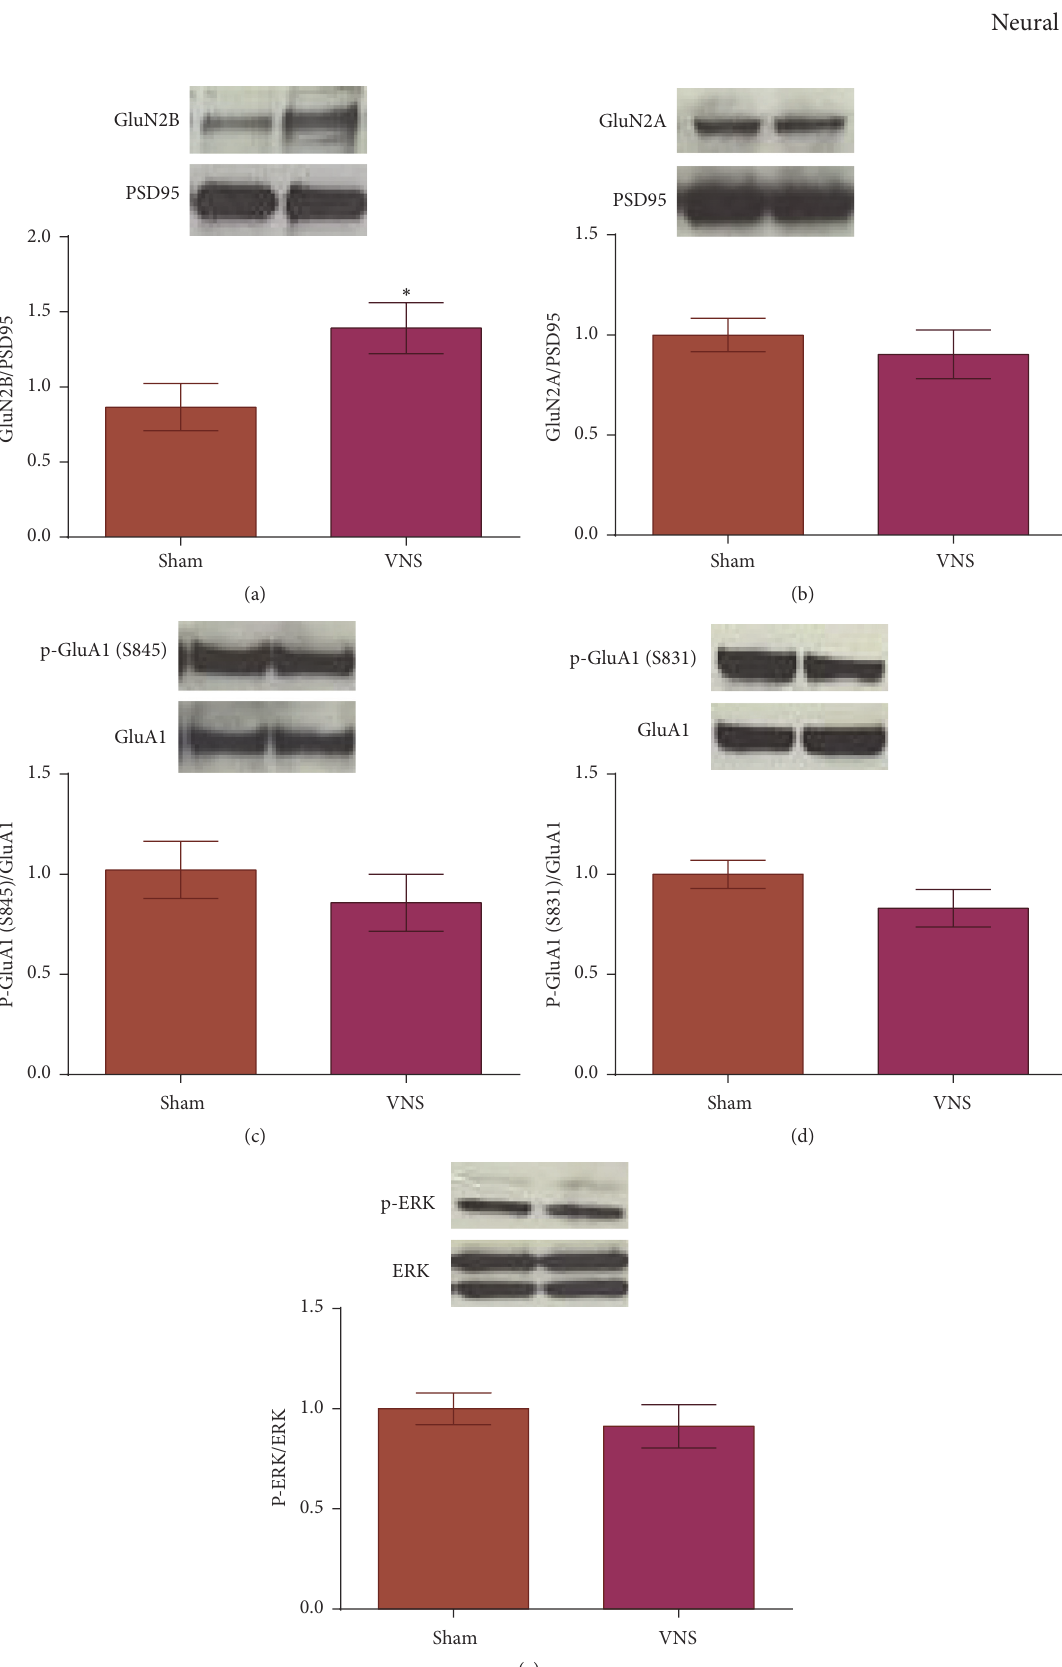
Figure 2: Increased expression of GluN2Bin the BLAof rats given VNS during fear extinction training. (a) Rats given VNS during extinction training show higher levels of GluN2B compared to rats given sham stimulation ( ∗ 𝑝 < 0.05 ). (b–e) No significant difference in expression of GluN2A, p-GluA1 at S845 or S831, or p-ERK across